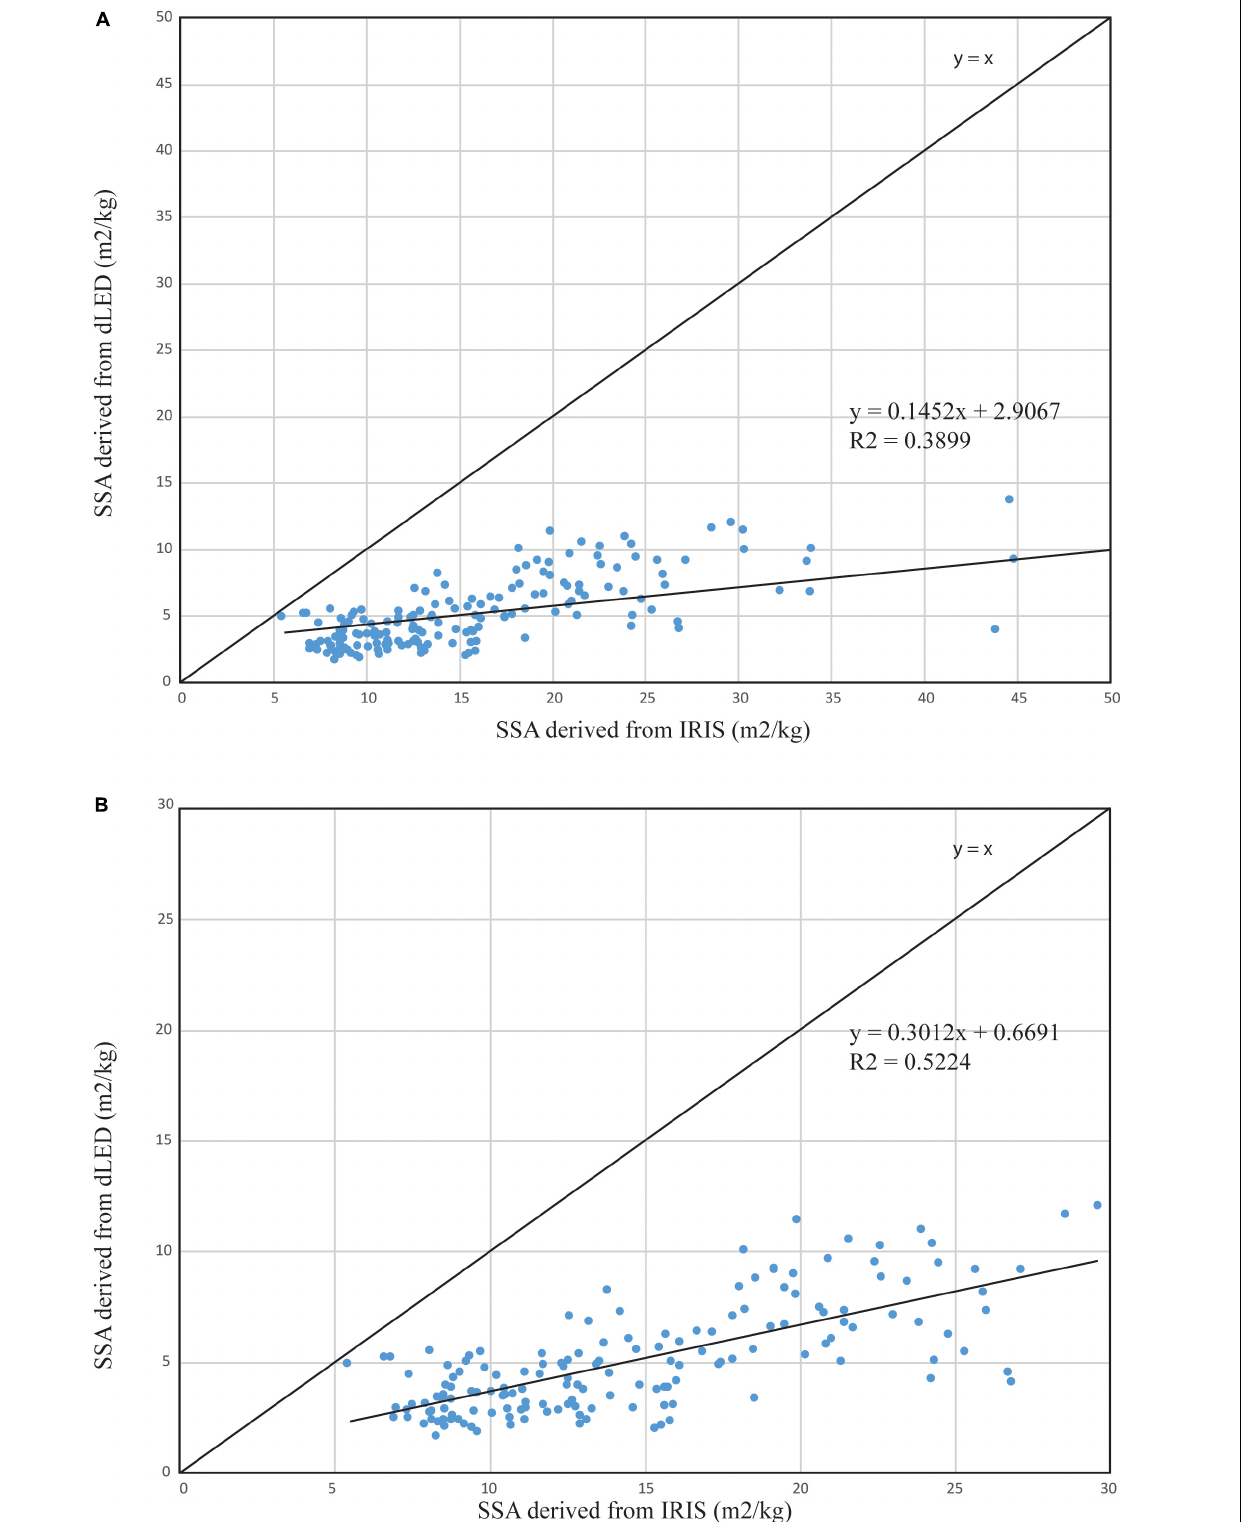
Frontiers in Earth Science |